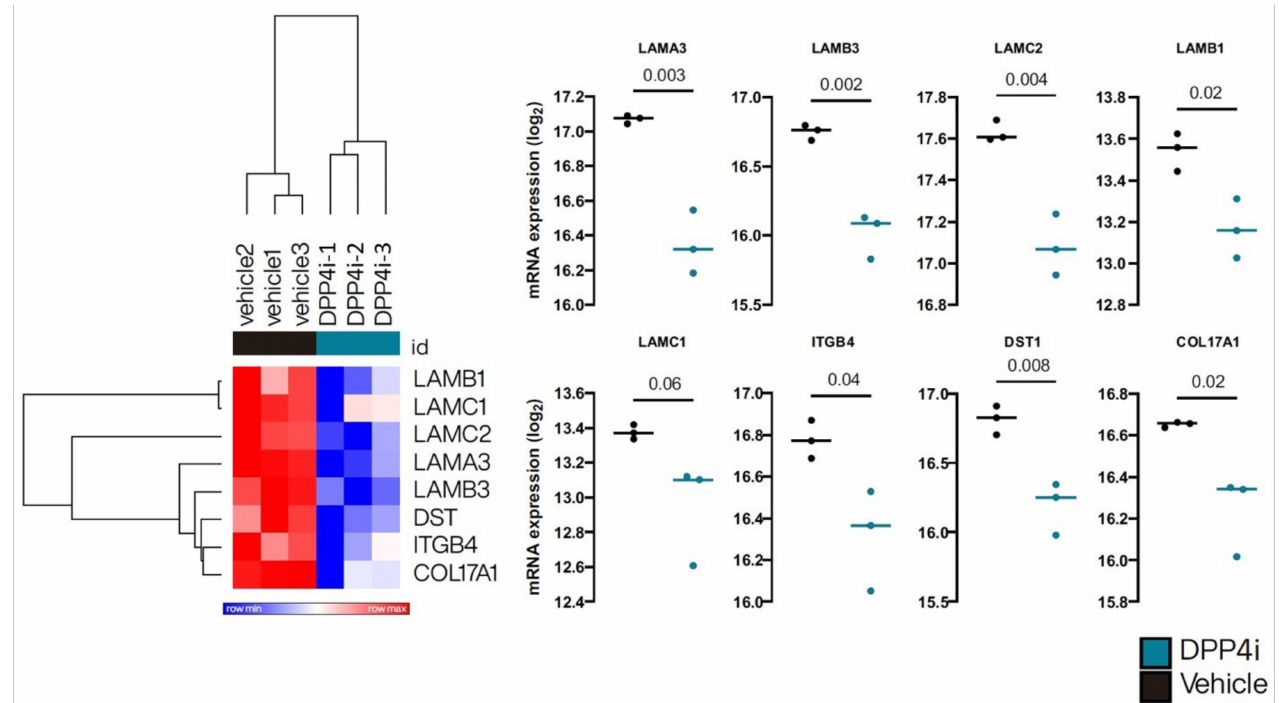
Figure 2. DPP4i treatment downregulates the expression of genes related to the dermoepidermal junction. Heatmaps showing the relative expression of LAMB1 , LAMC1 , LAMC2 , LAMA3 , LAMB3 , DST , ITGB4 , and COL17A with or without DPP4i treatment using Euclidean distances and hierarchical grouping. Scatter plots show the expression of individual genes with or without DPP4i treatment. Comparisons between groups were performed using an unpaired two-tailed t -test. p -values are marked on the graphs, and p < 0.05 was considered statistically